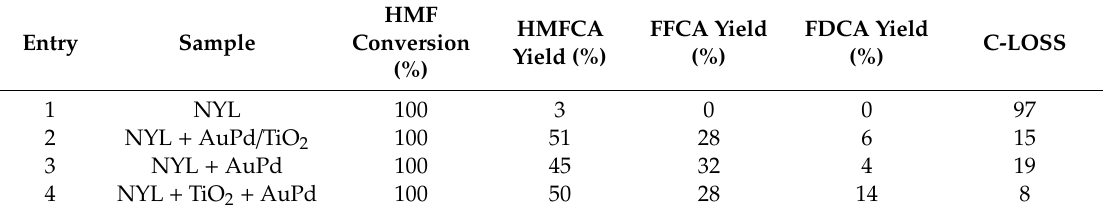
Table 3. Catalytic performances of NYL-derived materials. Reaction conditions: 4 h, 70 ◦ C, O 2 pressure